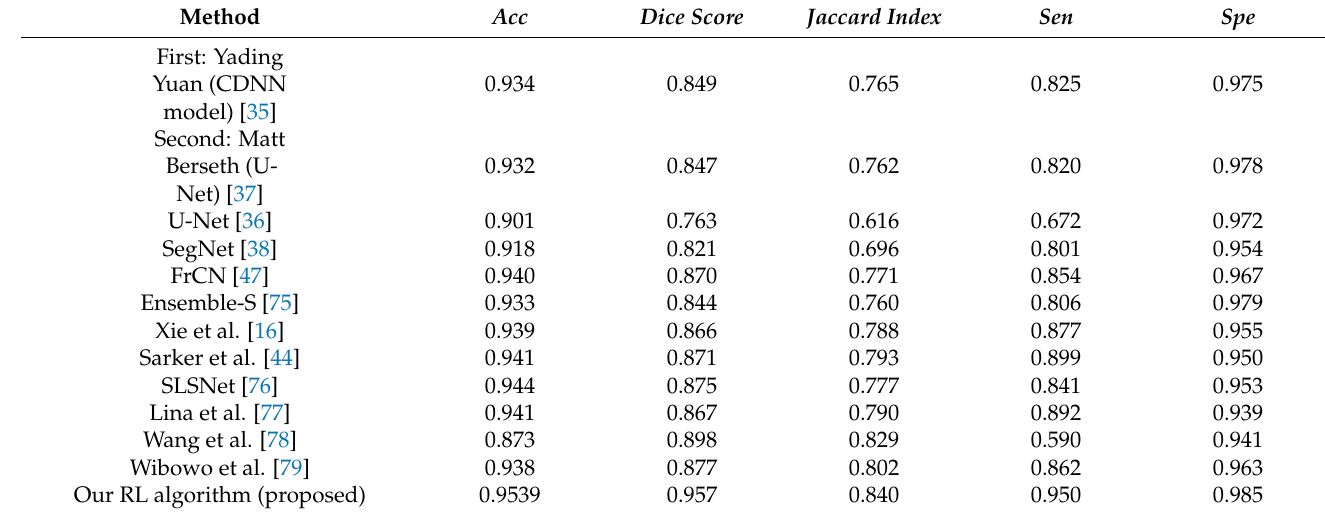
Table 3. Results comparison of our proposed RL method and the state-of-the-art methods on the ISIC skin lesion segmenta- tion challenge 2017